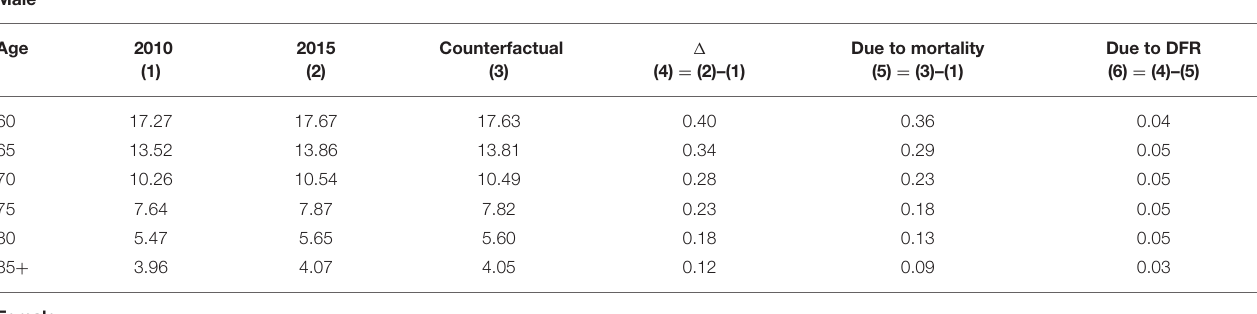
TABLE 4 | The effect of changes of the mortality and disability-free rate of the elderly on HLE from 2010 to 2015.